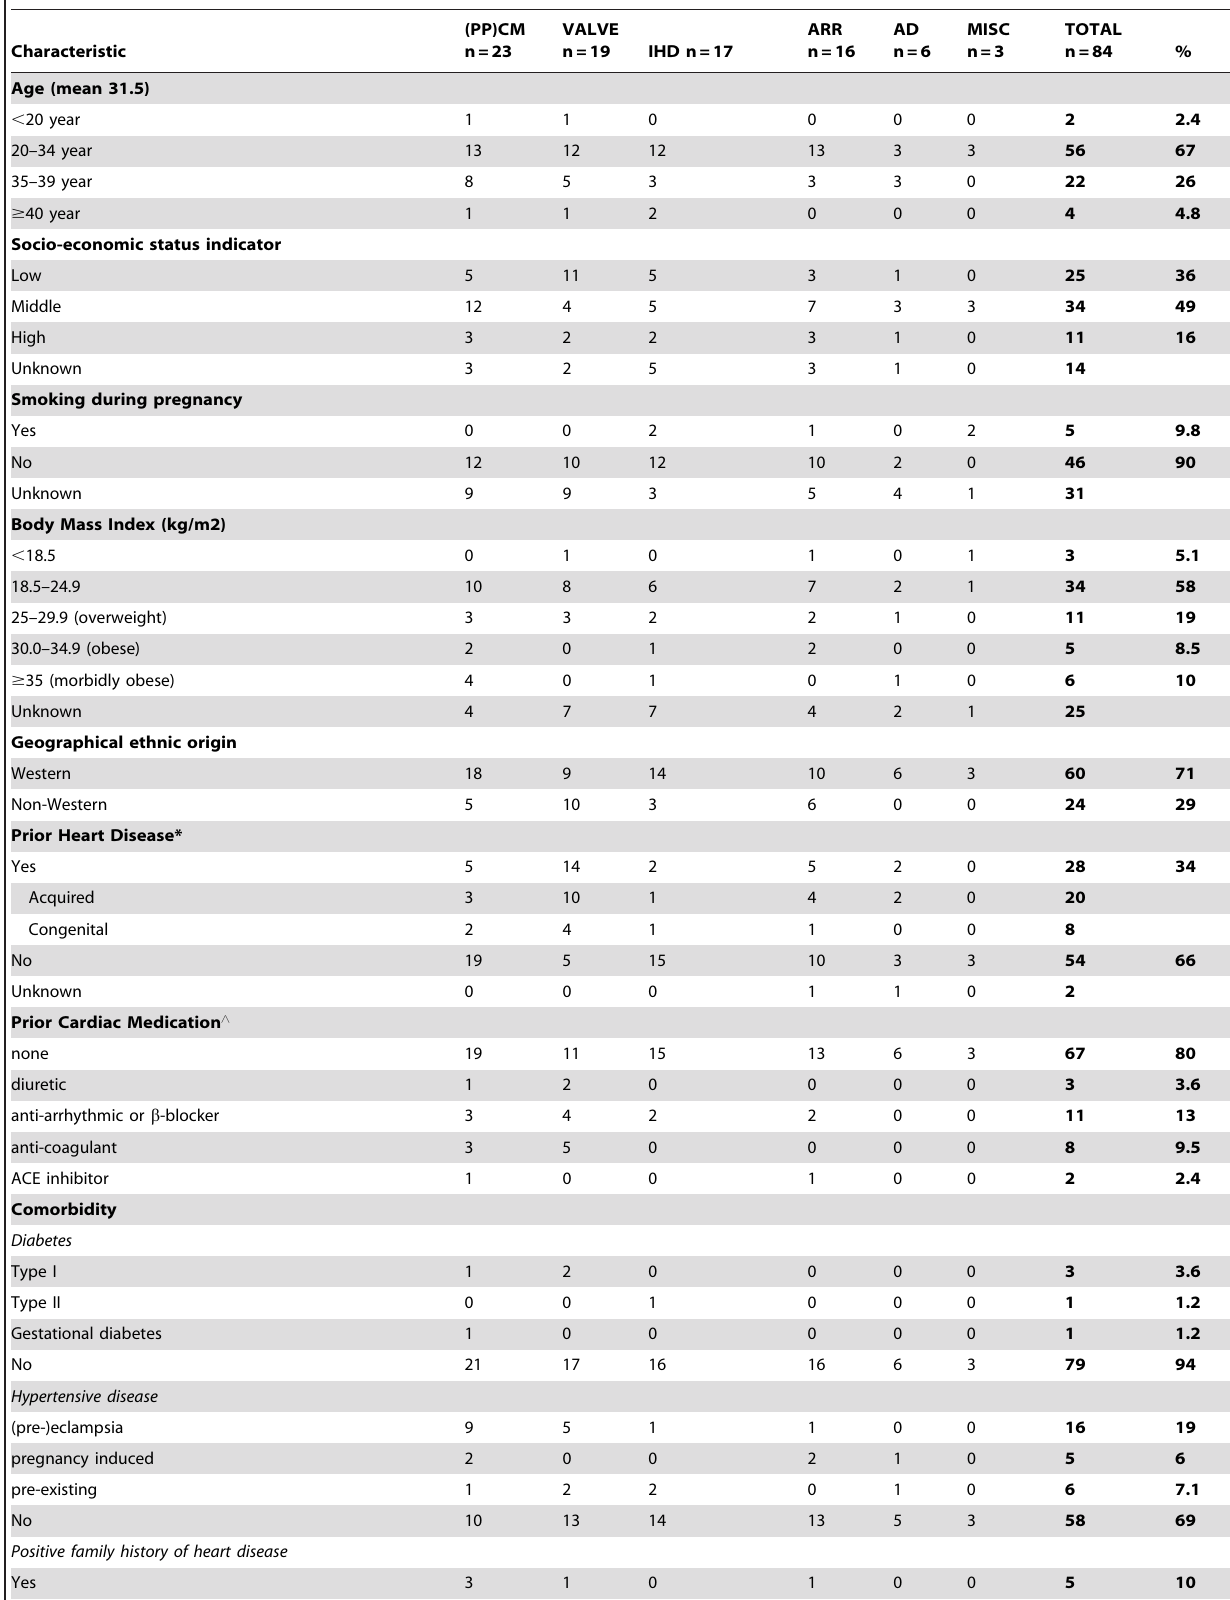
Table 2. Characteristics of women with severe maternal morbidity caused by cardiovascular